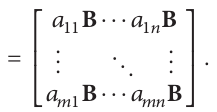
algorithm based on backstepping sliding mode